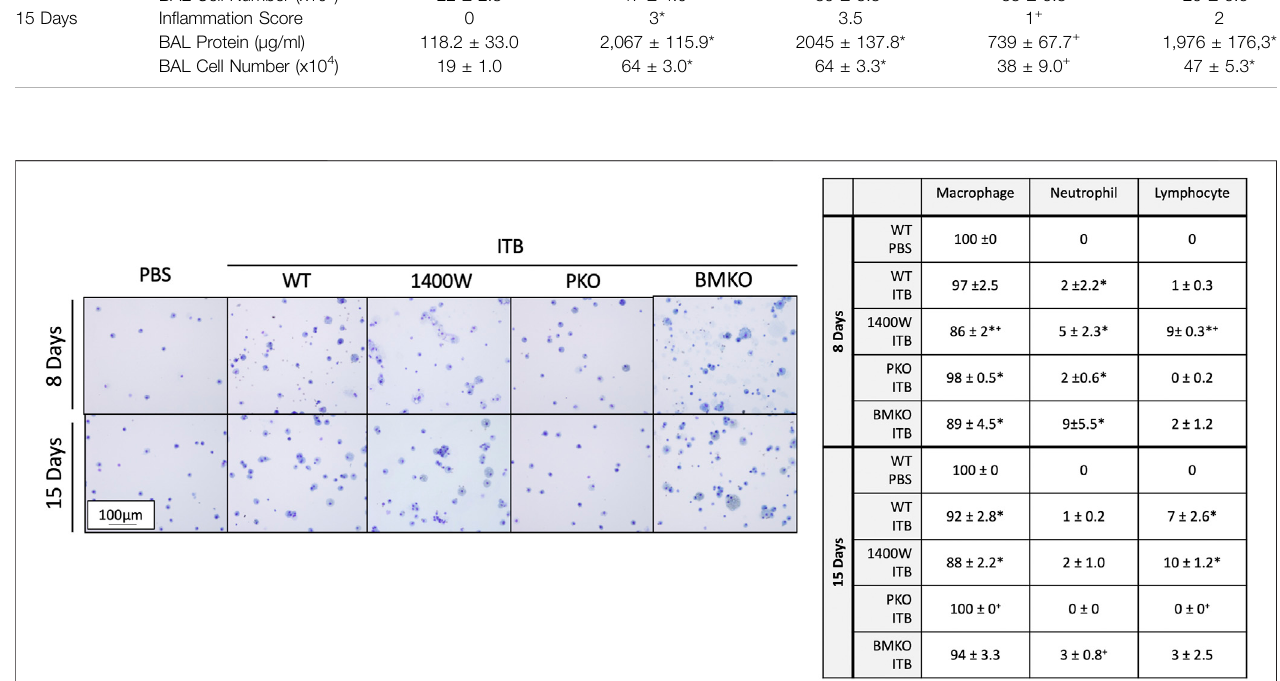
FIGURE 8 | BAL cells include macrophages, neutrophils, and lymphocytes. Cells collected by bronchoalveolar lavage were assessed by morphology and size to identify cell type. Macrophages, neutrophils, and lymphocytes were identi fi ed and quanti fi ed. ( n = 3 – 7 per group) * p < 0.05 compared to PBS, + p < 0.05 compared to